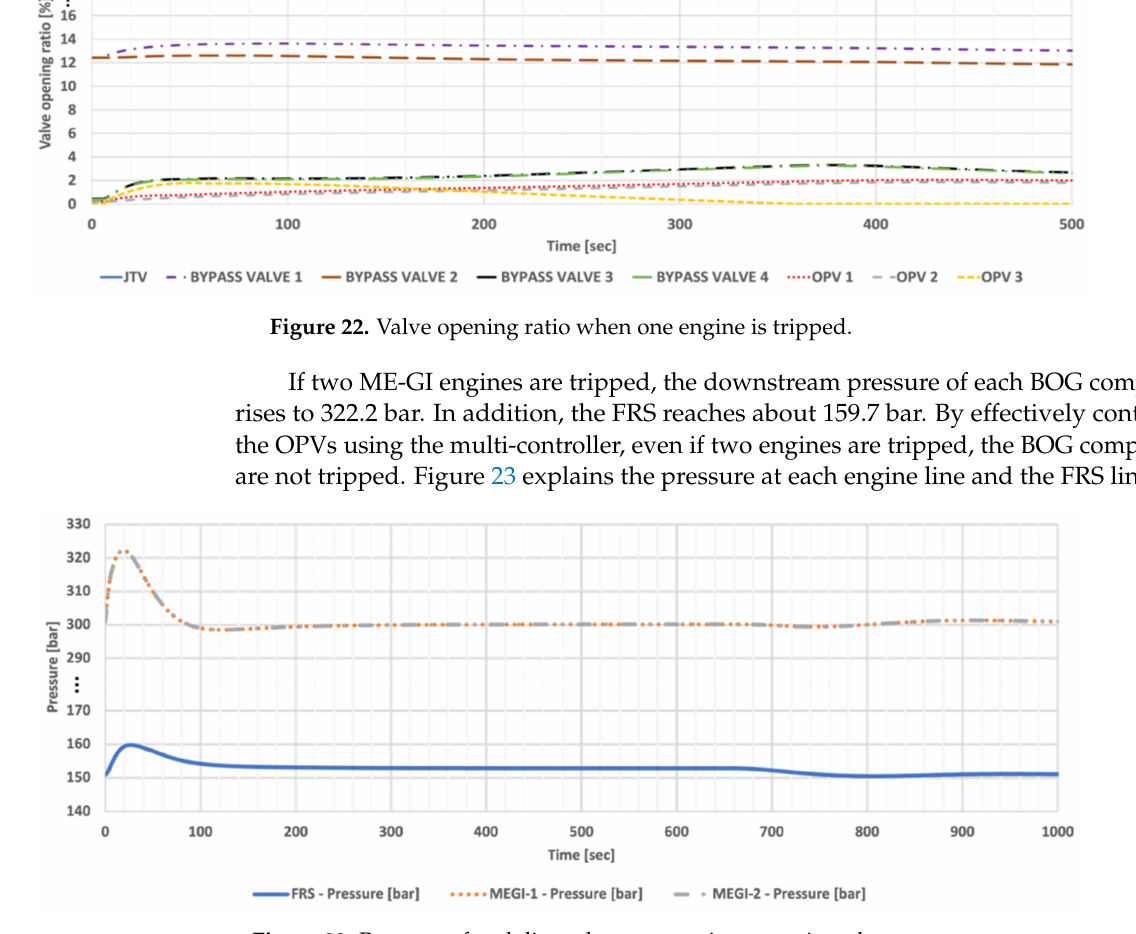
Figure 23. Pressure of each line when two engines are tripped.